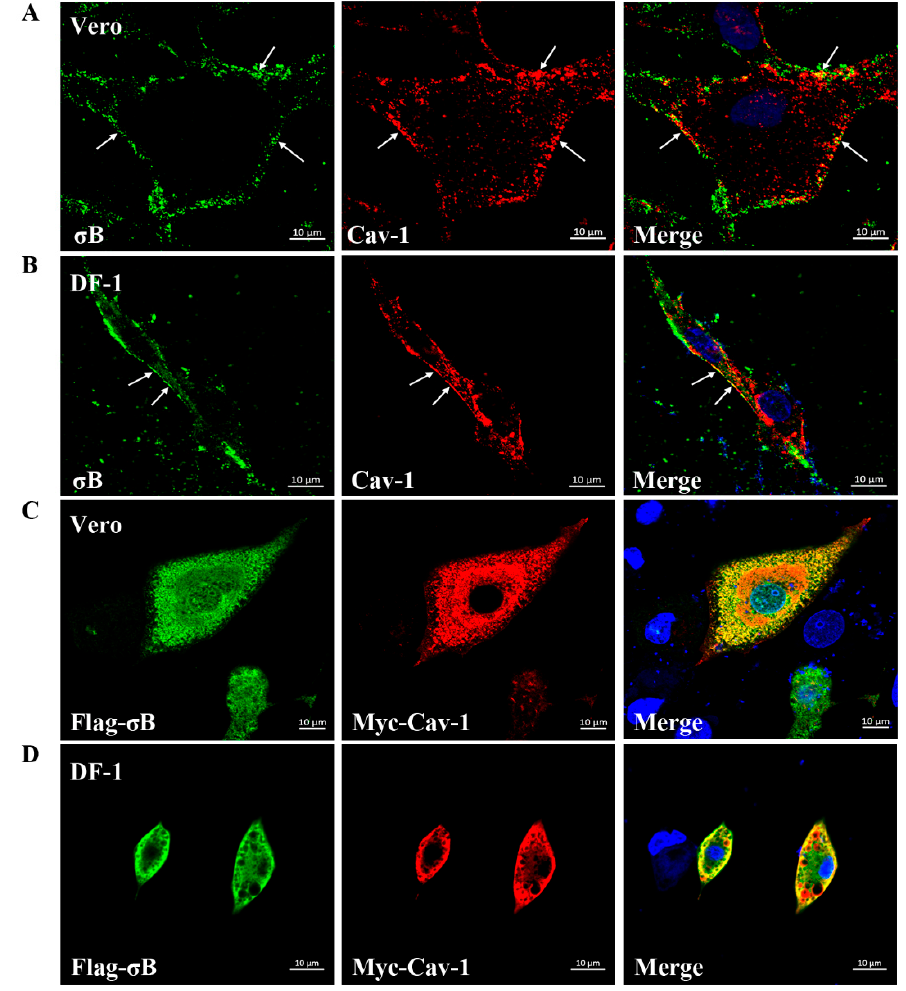
Figure 2. Co-localization of σ B with Cav-1. ( A , B ) Vero ( A ) and DF-1 ( B ) cells were infected with ARV at an MOI of 10. By immunostaining using antibodies against σ B (green) and Cav-1 (red), co- localization of σ B with Cav-1 was detected at 40 min post-infection. DAPI was used to stain the nuclei (blue). The white arrows indicate co-localization sites at the cell membrane (yellow). ( C , D ) Vero ( C ) and DF-1 ( D ) cells were co-transfected with plasmid pCDNA-Flag- σ B and pCDNA-Myc-Cav-1. Immunostaining was conducted using monoclonal antibodies against Flag (green) and Myc (red). DAPI was used to stain the nuclei (blue). A large number of co-localization sites (yellow) of σ B with Cav-1 were detected at 36 h post-transfection.